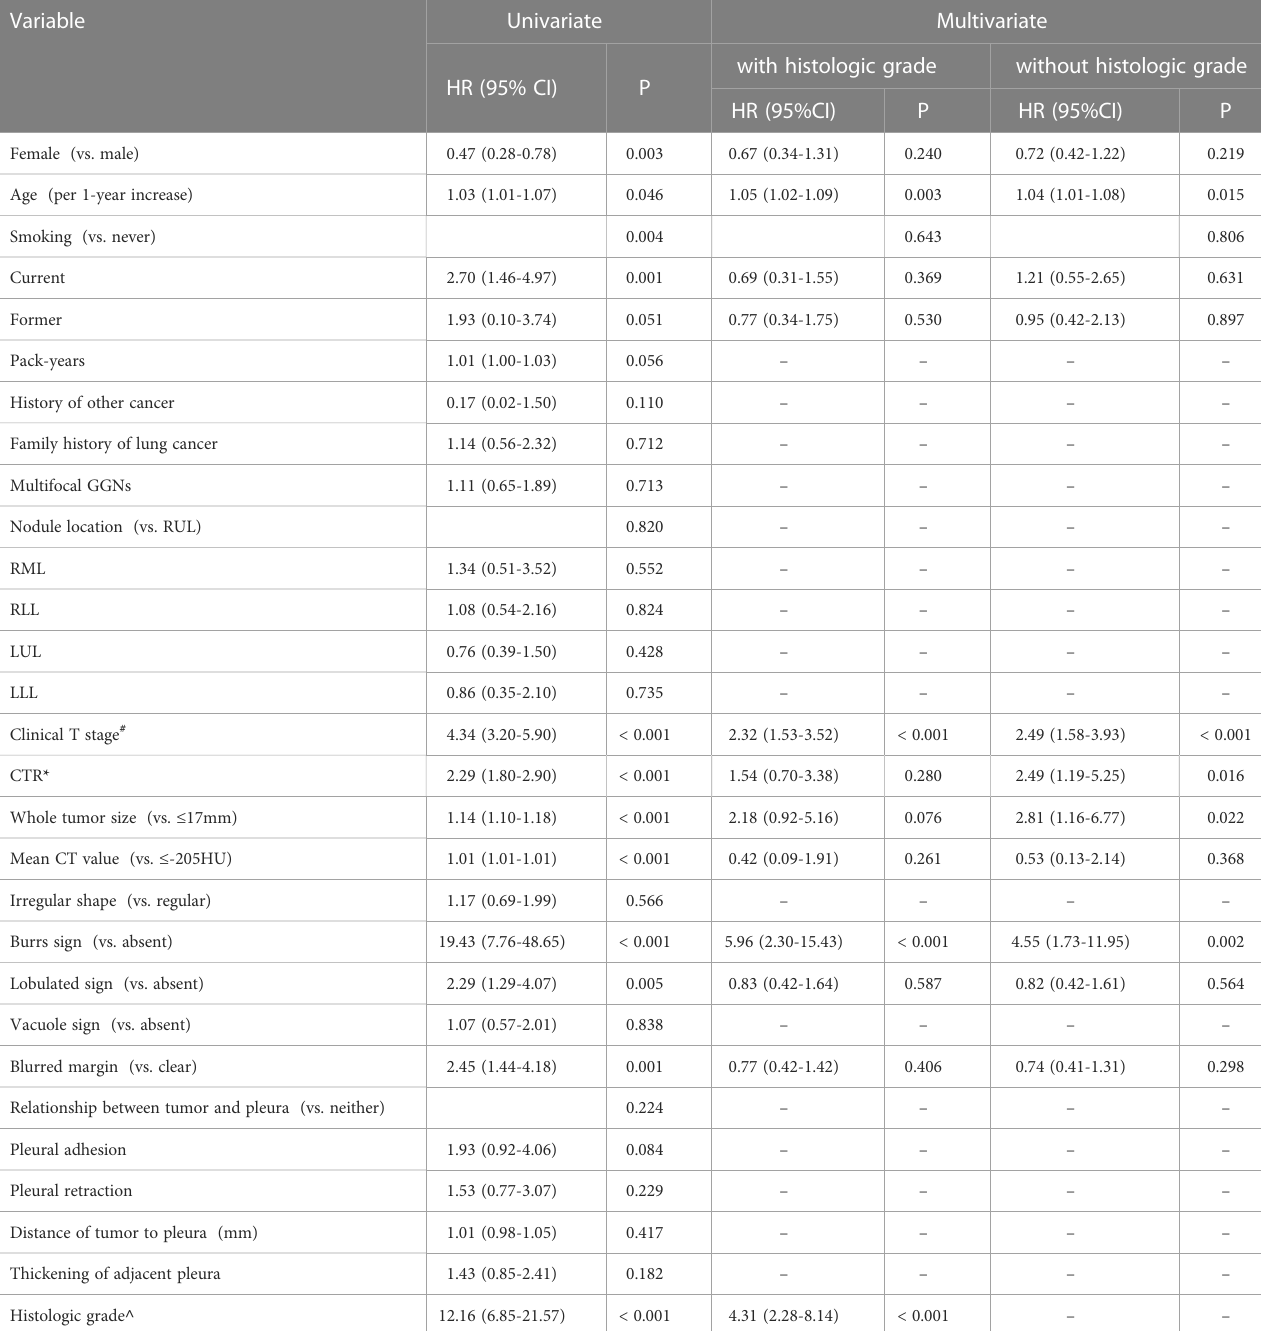
TABLE 3 Univariate and multivariate cox regression analysis for disease-free survival. Variable